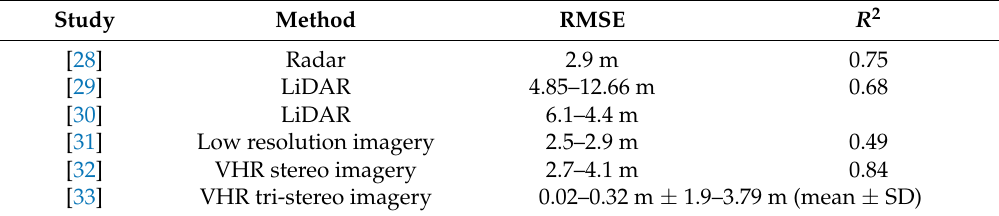
Table 2. Accuracies of methods for estimating forest height from satellite data. VHR: very high resolution.